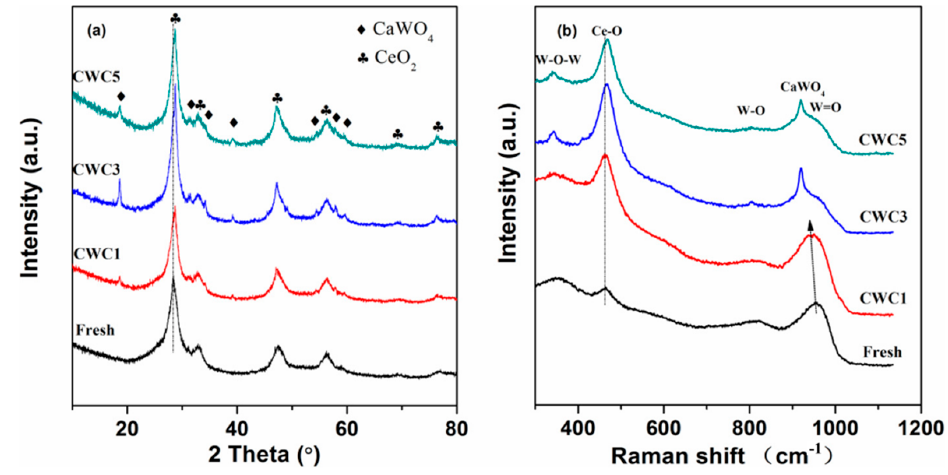
Figure 9. XRD patterns ( a ) and Raman spectra ( b ) of fresh and Ca poisoned catalysts [58].